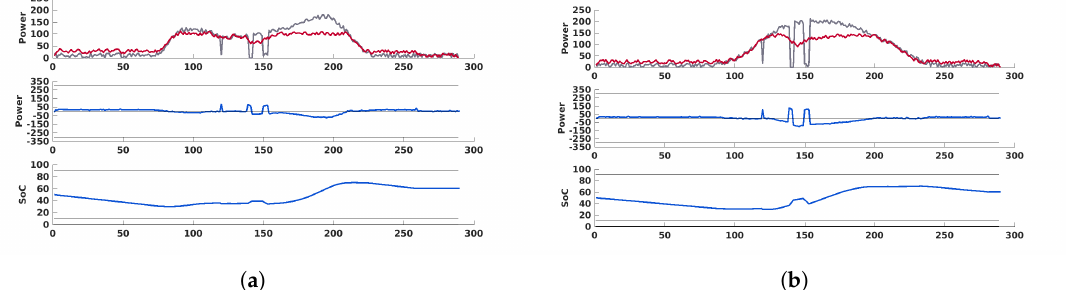
Figure 13. Top: Grid power flow with RC ( P g , red) and without RC ( P hcpv , grey). Middle: Battery power evolution ( P ess , blue) and constraints (grey). Bottom: Battery SoC evolution (blue) and constraints (grey). On a cloudy day case ( a ), on a sunny day ( b ).